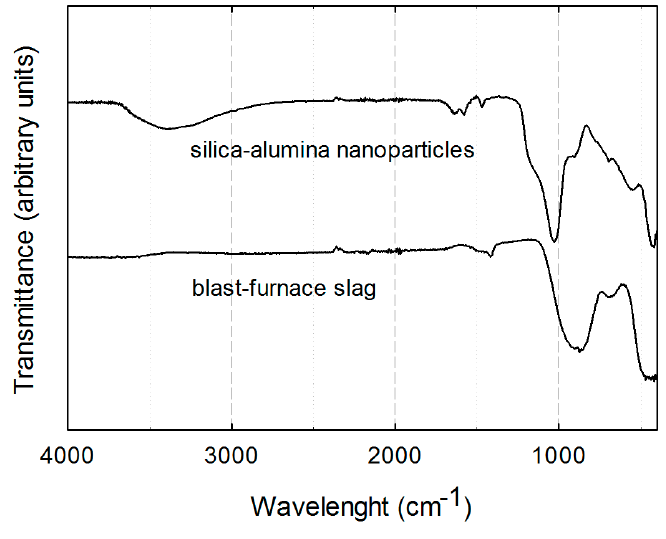
Figure 9. FT-IR spectra of blast-furnace slag and the silica-alumina nanoparticles.